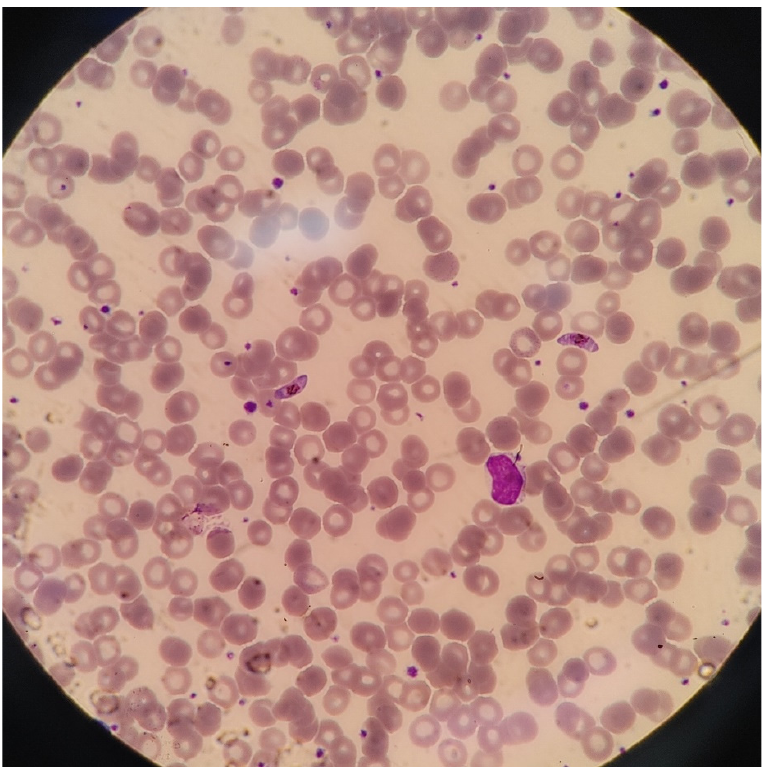
Figure 1. Peripheral smear for blood cell morphology showing P. falciparum gametocytes (Magni- fication, ×400, Wright stain).